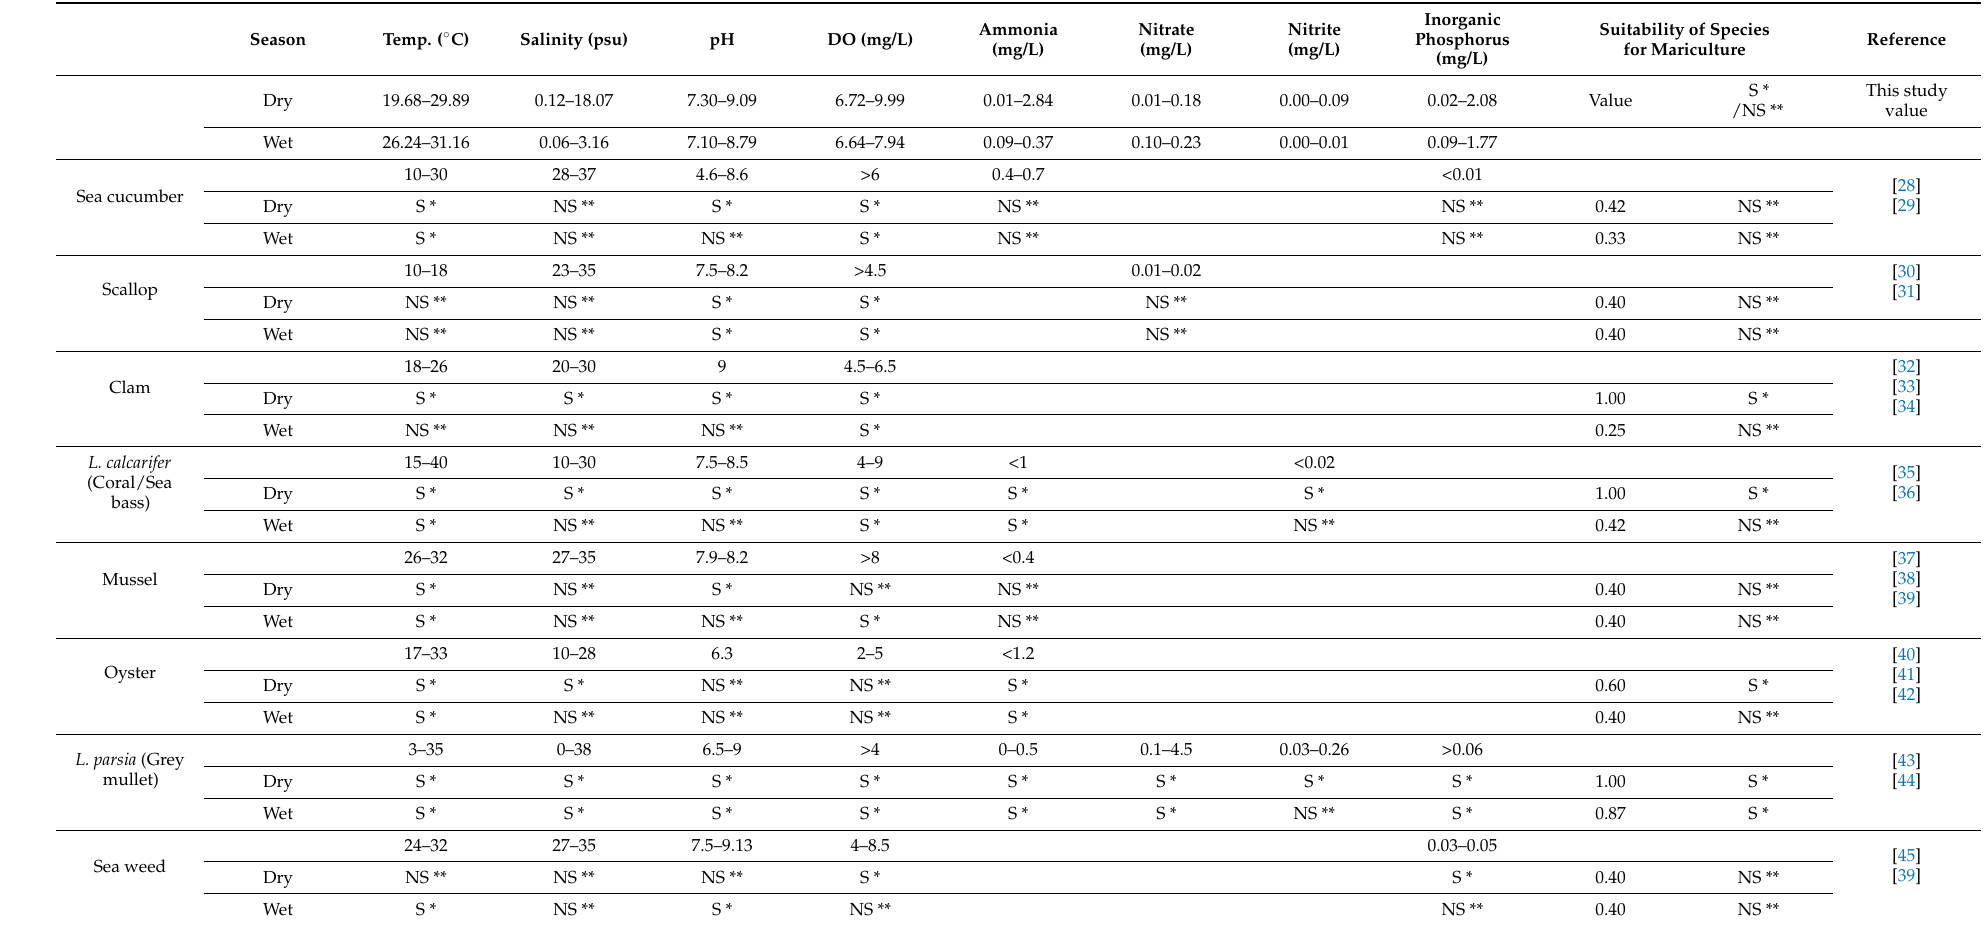
Table 4. Suitability index for mariculture of the commercially important fisheries species in the